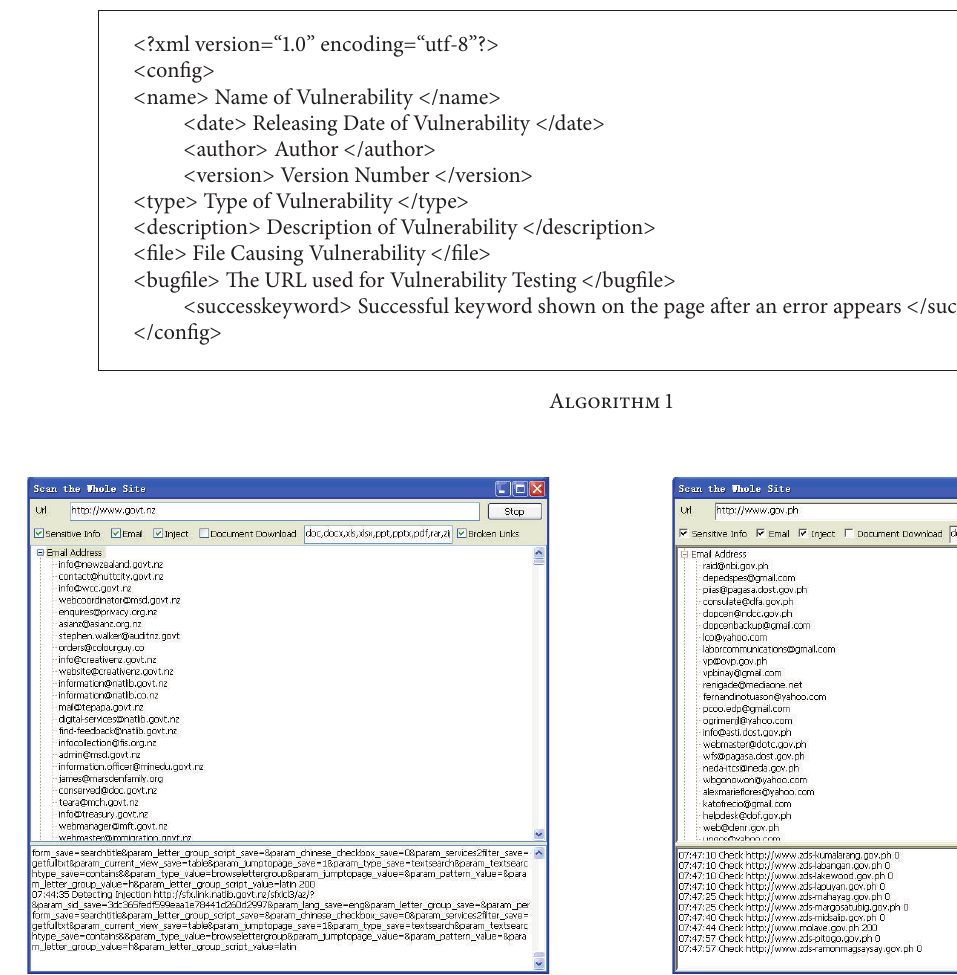
Figure 15: Leaked e-mail addresses in portal website of New Zealand.